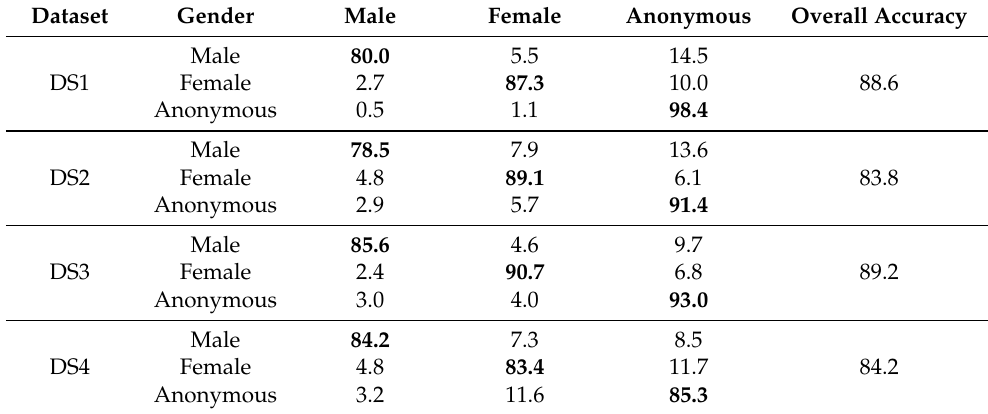
Figure 4. The gender distribution for each dataset in terms of percentage. Table 5. Confusion matrix of the proposed gender classification method on the dataset in terms of